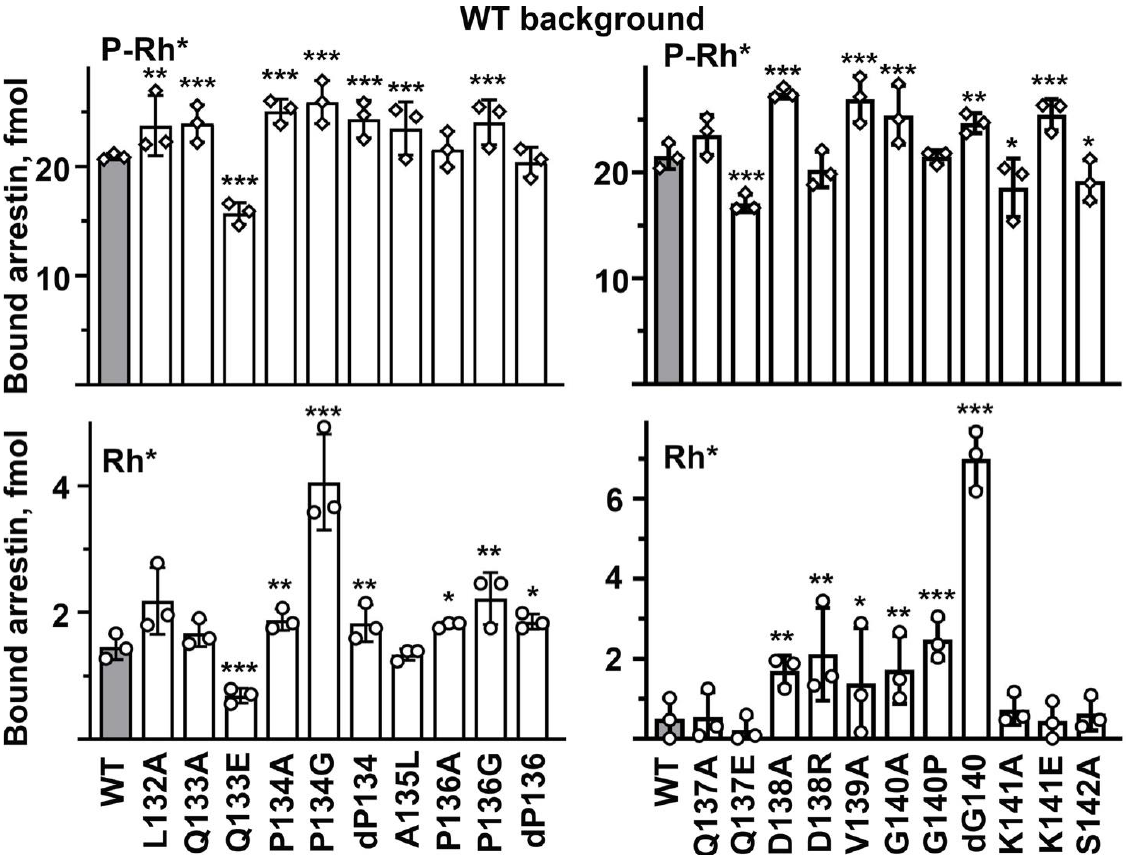
Figure 3. The effect of middle loop mutations on WT background on arrestin-1 binding to rhodopsin. The binding of indicated mutants of arrestin-1 to P-Rh* and Rh* was determined using radiolabeled arrestins, produced in cell-free translation, in the direct binding assay with purified phosphorylated or unphosphorylated light-activated bovine rhodopsin, as described in Methods. In the mutation names, “d” here and in the following figures stands for deletion, same as “Δ” in the text. Circles represent individual measurements performed in duplicate ( n = 3). The binding to P-Rh* and Rh* was analyzed separately in each of the two groups. Statistical significance of the differences between WT (darker shaded bars) and the arrestin-1 mutants was determined by ANOVA followed by Dunnet post hoc test with correction for multiple comparisons and is indicated as follows: * p < 0.05; ** p < 0.01; *** p < 0.001 to